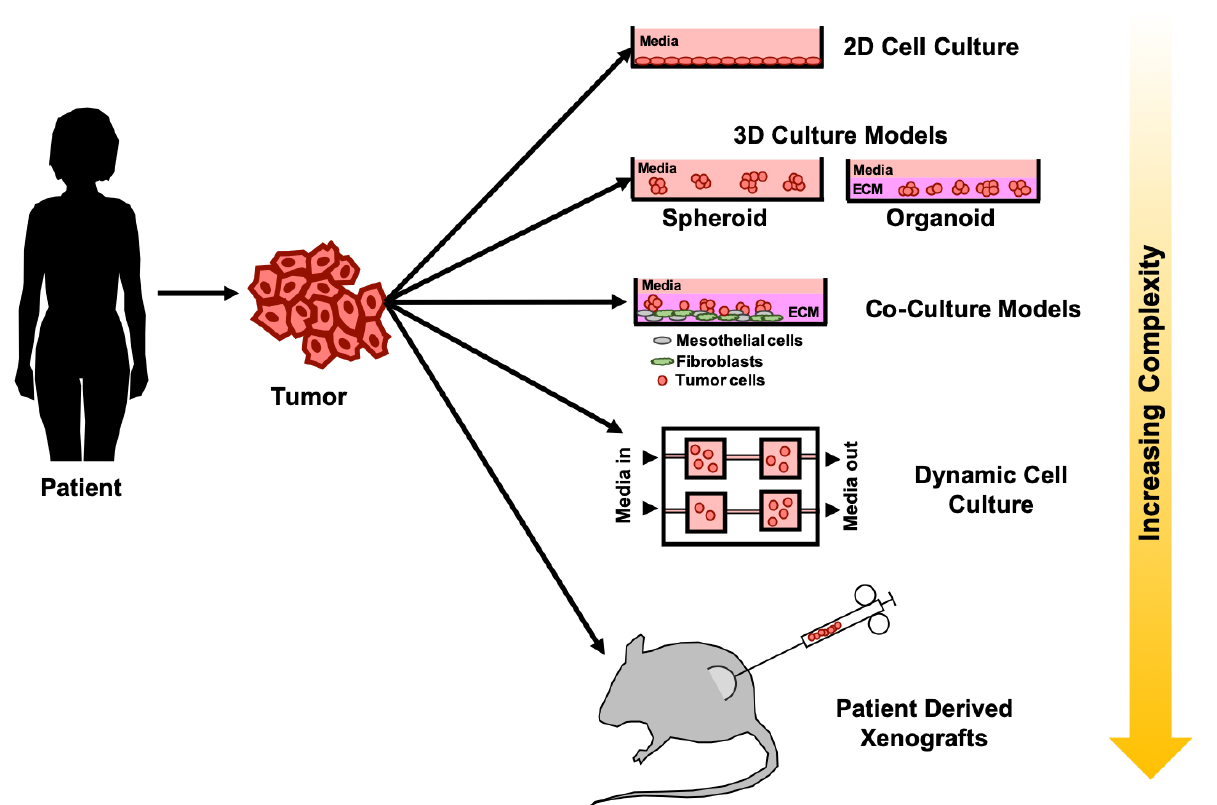
Figure 4. Evolution of pre-clinical models in ovarian cancer for drug testing.